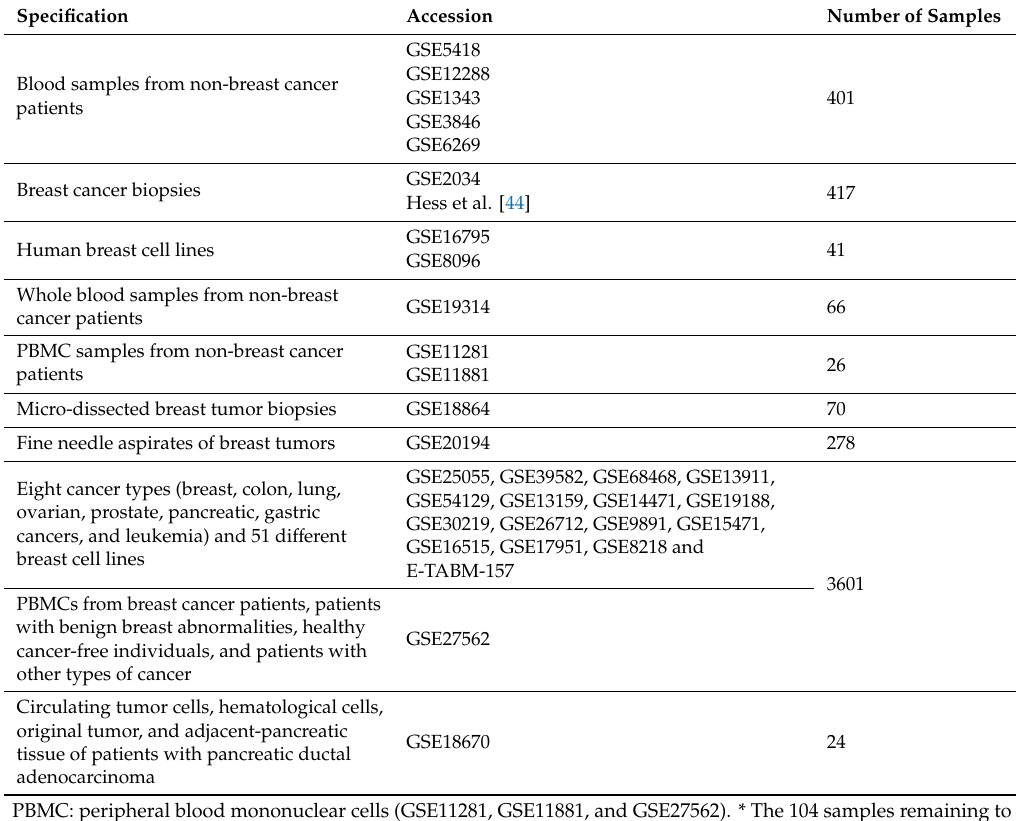
Table 1. Datasets used for discovery and external validation of the 80 genes